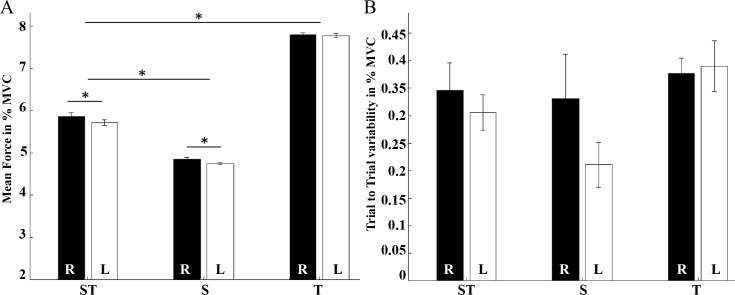
Behavioral data.(A) Mean force and (B) Trial to Trial variability during the high spatial and high temporal (ST-), high spatial and low temporal (S-) and low spatial and high temporal (T-) processing demands condition with the right (black, R) and left (white, L) hand. Error bars indicate standard error in percent maximal voluntary contraction (% MVC). Significant differences (p < 0.001) are marked (*).